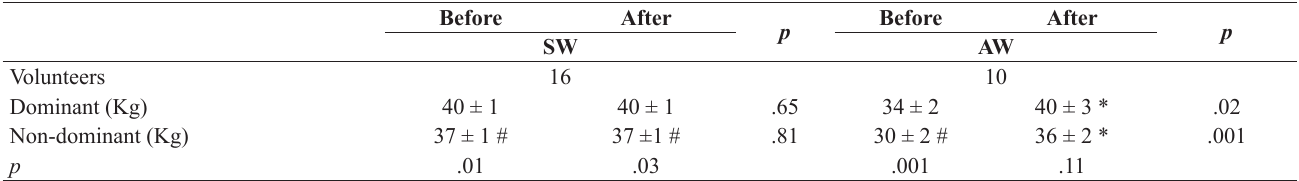
Table 6. Grip strength before and after the 6-month stretch break program.